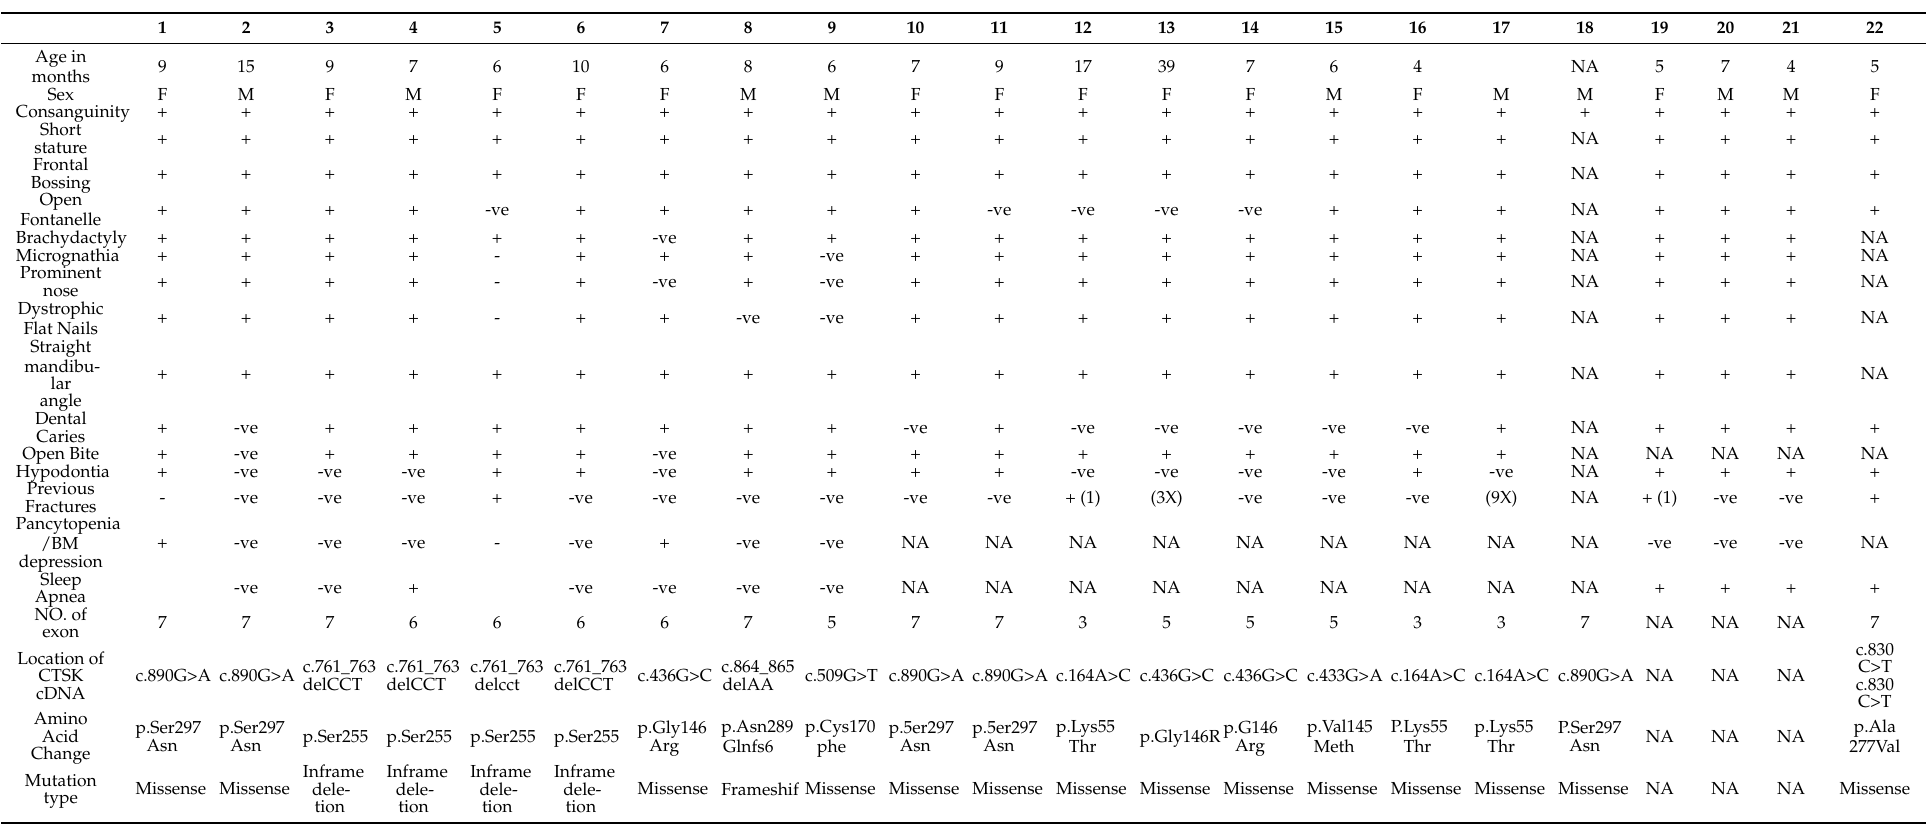
Table 1. Clinical, Radiological, Biochemical, Oro-dental and Molecular data for all 22